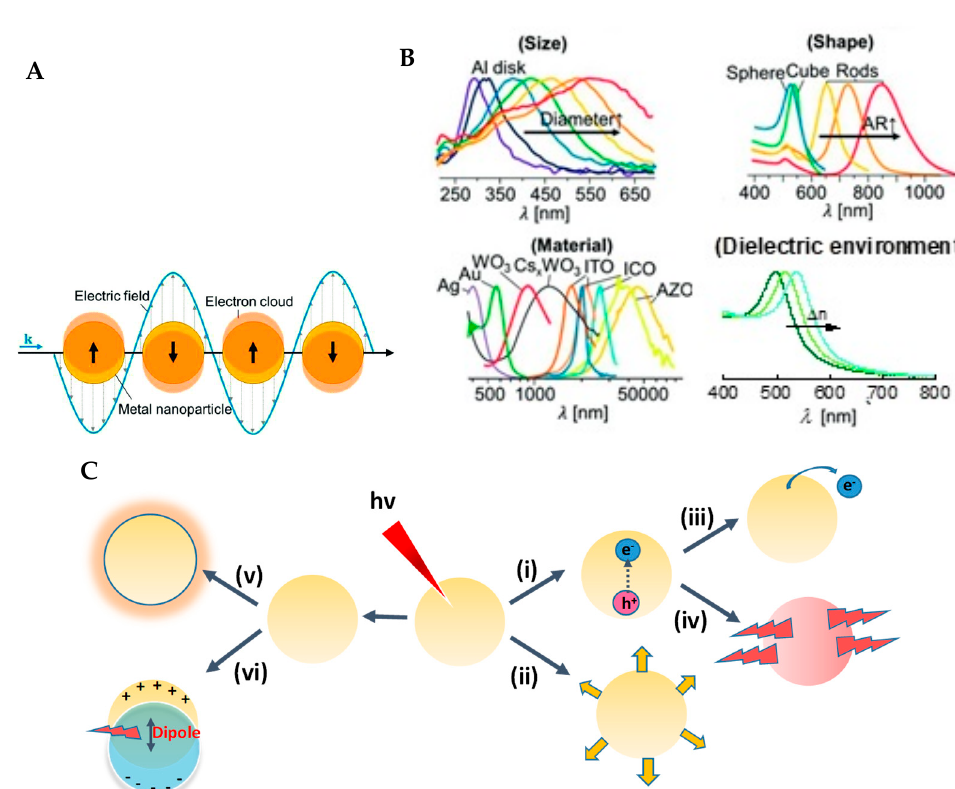
Figure 1. ( A ) Coherent collective oscillations of free electrons of metal nanoparticles in response to light when the diameter of the nanoparticles is smaller than the wavelength of light. ( B ) Plasmonic resonances are engineered by the size [23], shape [24], material composition of nanomaterials [25], and dielectric environment (n = 1.00 to 1.50). ( C ) The decay processes of excited surface plasmon resonance waves: ( i ) non-radiative decay by the excitations of charge carries; ( ii ) radiative decay via scattering, ( iii ) transfer of hot charge carriers to the surrounding; ( iv ) relaxation via heat transfer, ( v ) electromagnetic field enhancement, and ( iv ) dipole resonance energy transfer.